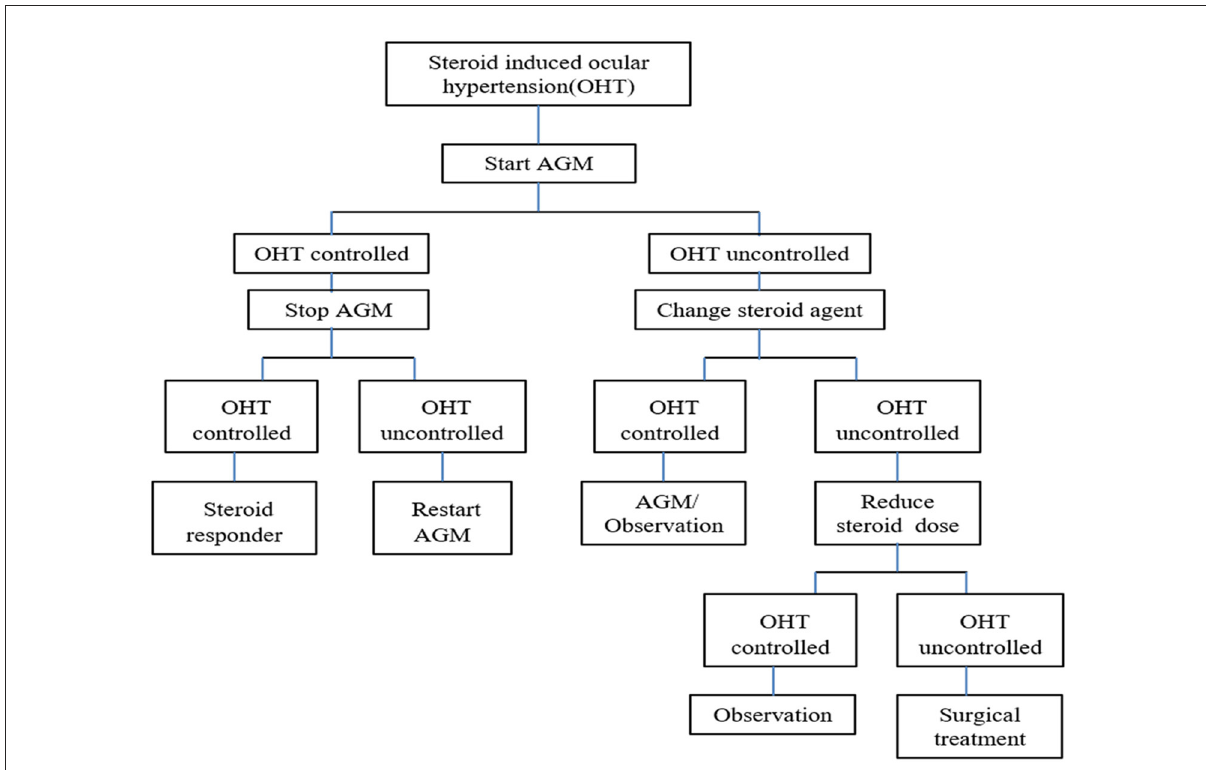
FIGURE1 Protocol of management on OHT in flow chart for children with NHL. AGM, antiglaucoma medication; NHL, non-Hodgkin